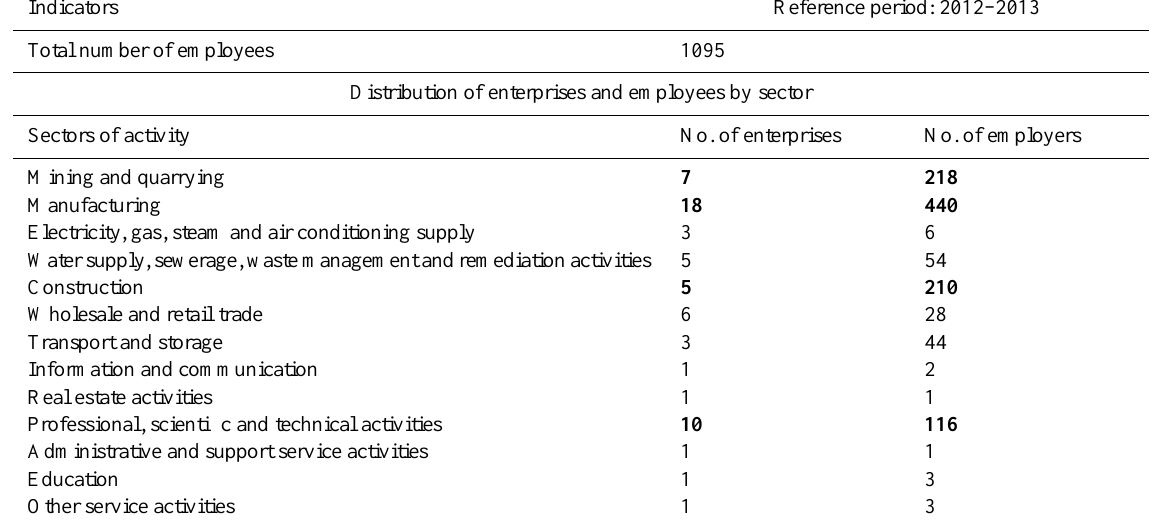
Table 3. Distribution of enterprises and employees by industrial sector for Alta Val d’Agri industrial area (the most significant sectors in bold).